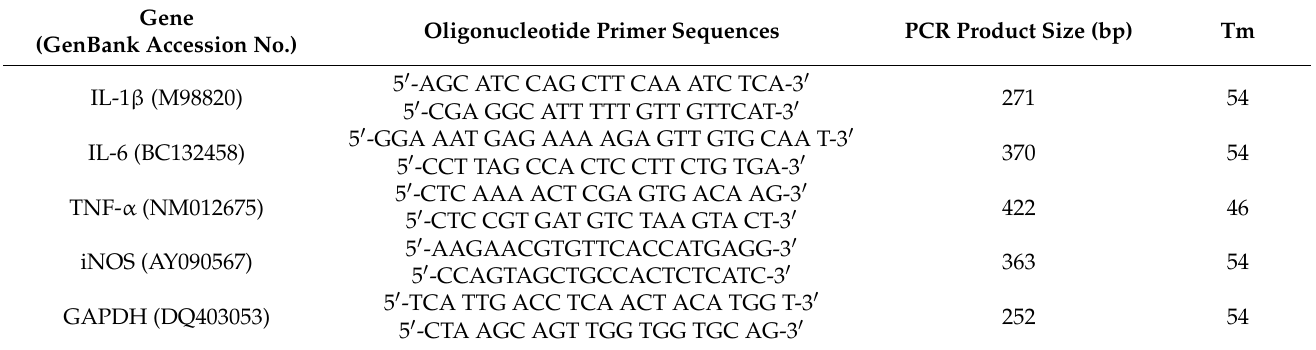
Table 1. Oligonucleotide primers used in RT-PCR